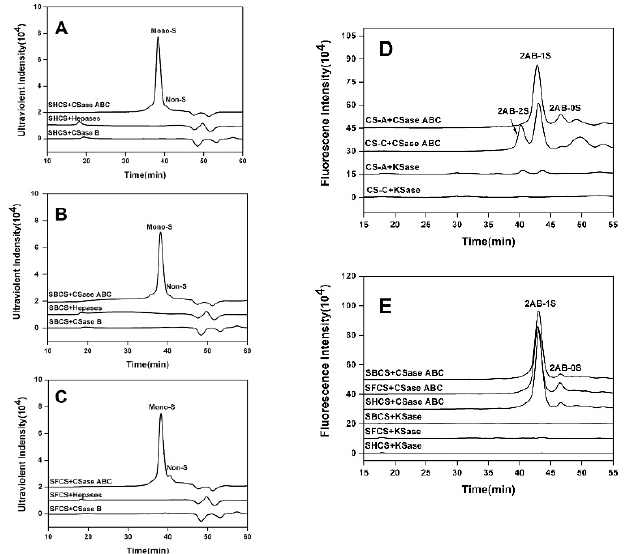
Figure 1. Analysis of GAG-lyase-treated CS preparations by gel filtration chromatography. SHCS ( A ), SBCS ( B ), and SFCS ( C ) were treated with CSase ABC, Hepases, and CSase B, respectively, and the resultants were analyzed by gel filtration with a UV detector. Mono-S, the monosulfated disaccharides; Non-S, non-sulfated disaccharides. To determine the content of KS impurity in commercial